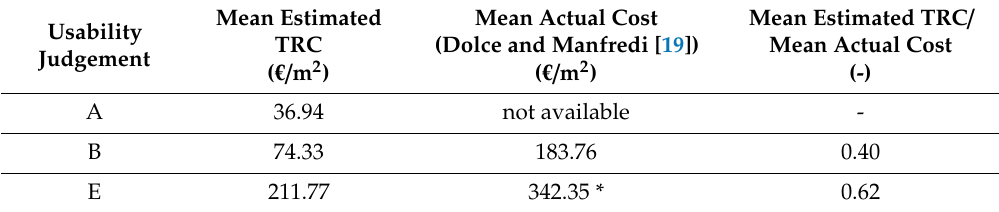
Table 7. Comparison between mean estimated TRC and mean actual repair